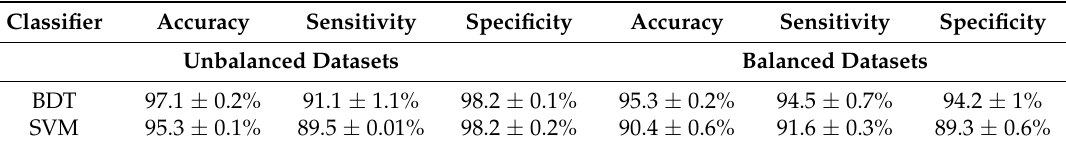
Table 5. Performance of stage 1: VF versus non-VF